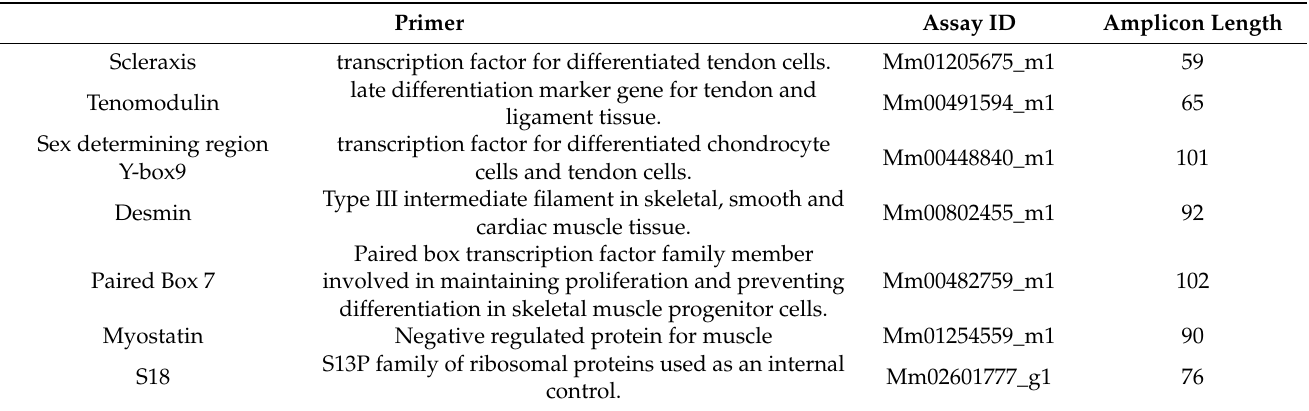
Table 1. Primer assay ID and amplicon length for real-time PCR.